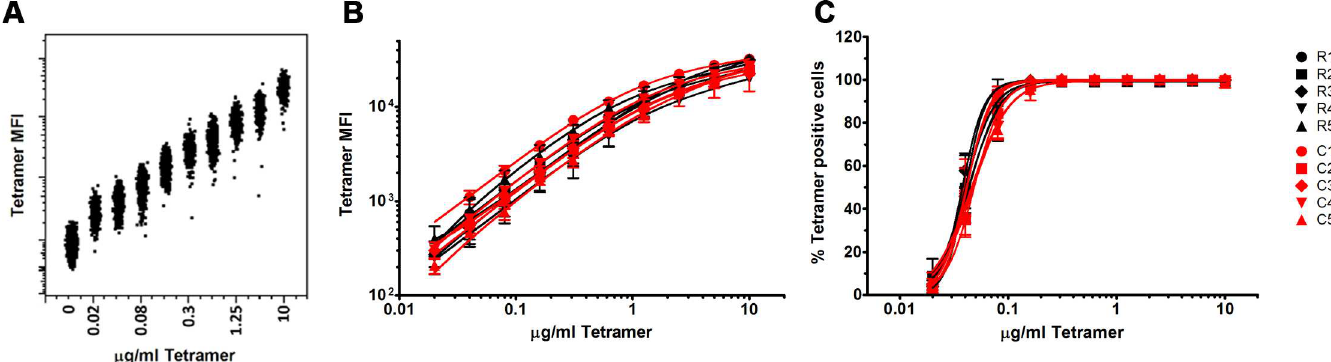
Fig 6. Comparable TCR avidity for individual T cell lines isolated form SR/SR and SR/CI patients. T cell lines were generatedfrom patients SR/SR-1 (Cell lines R1 to R5) and SR/CI-2 (Cell lines C1 to C5) as describedin Materials and Methods were stained with A2/NS3-1073tetramer at a range of concentrations (0.02–10 μ g/ml, two fold dilutions).Data are expressedas mean +/- SD of duplicatesamples in two independent experiments. (A) Representative FACS plot of single cell tetramer fluorescence intensity (MFI). (B-C) Tetramer titration curves. Mean fluorescence intensity (MFI, (B)) for each cell line/concentration and percentage (C) of tetramer positive cells for each cell